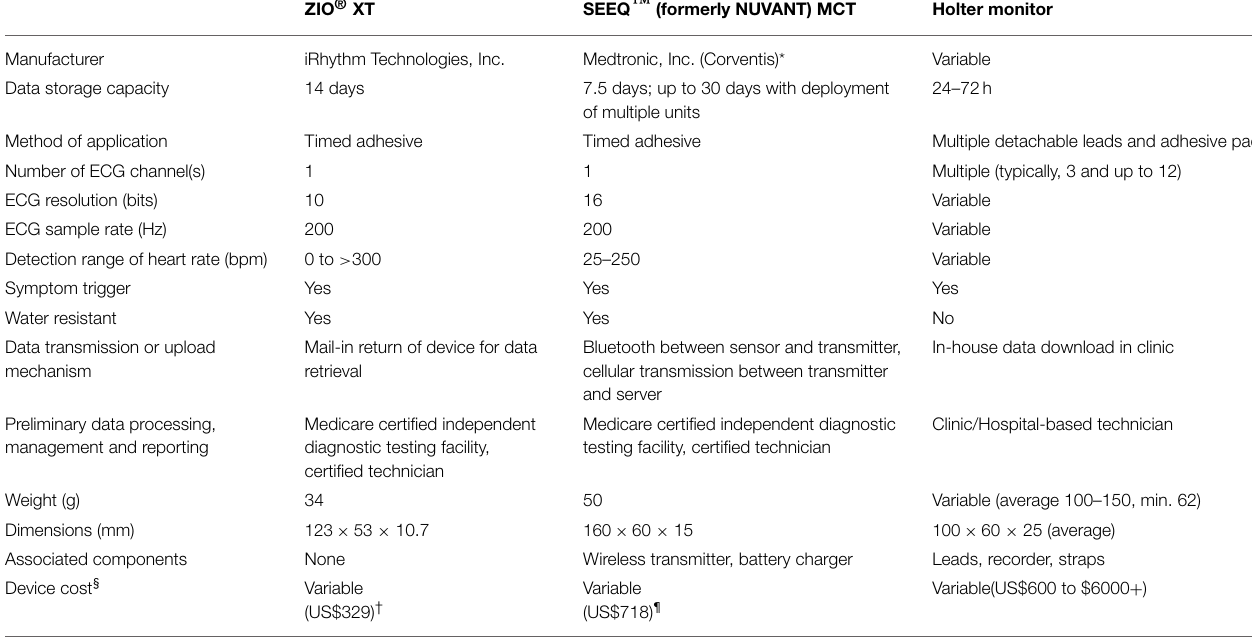
TABLE 1 | Comparison between two CE-marked, FDA-approved leadless, continuous electrocardiographic patch devices and the standard Holter